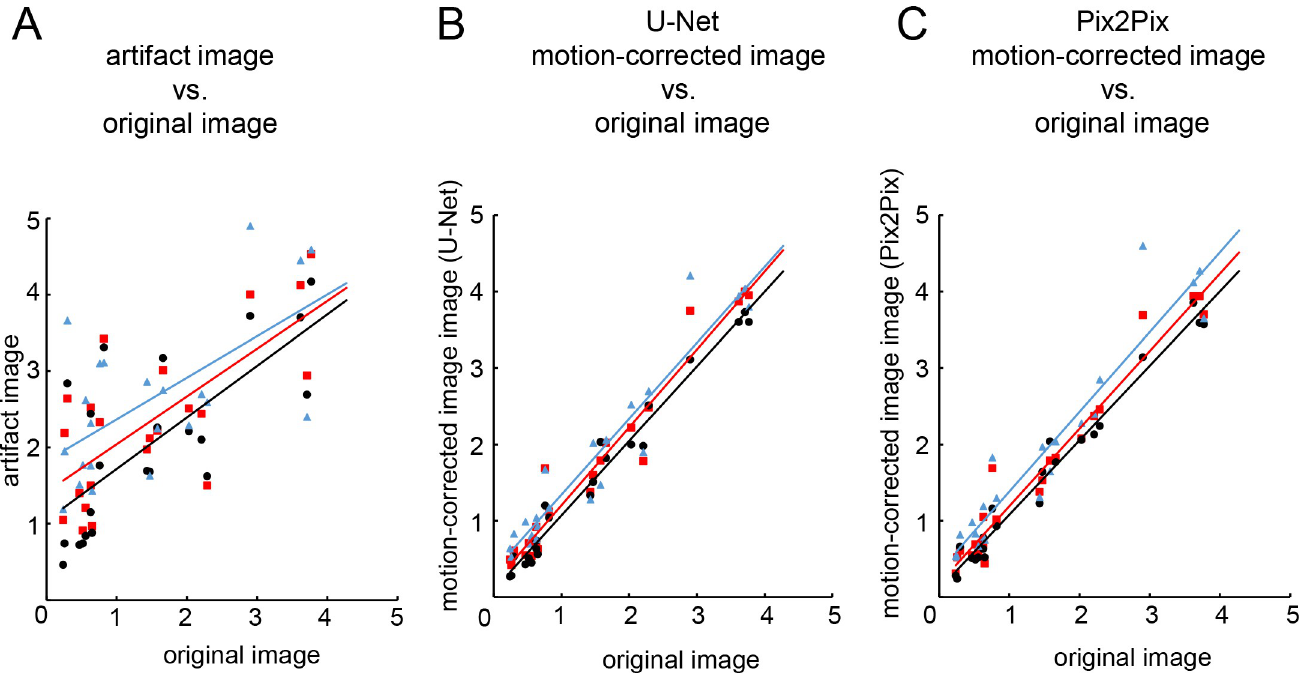
Fig 9. The Spearman’s rank correlation coefficient for the results of the VSRAD analysis. The results of the Spearman’s rank correlation coefficient are shown for (A): severity of voxel of interest (VOI) atrophy of artifact vs . the original image, (B): severity of voxel of interest (VOI) atrophy of U-Net motion-corrected vs . the original image and, (C): severity of voxel of interest (VOI) atrophy of Pix2Pix motion-corrected vs . the original image. The dotted line and white points plot show the relationship between the limits of agreement of the artifact image and the original image, and the solid line show the relationship between the limits of agreement of the motion-corrected image for U-Net or Pix2Pix and the original image. The rotation angle and k-space interval are plotted with 1˚_30 pixel in black, 2˚_20 pixel in red, and 3˚_10 pixel in blue.